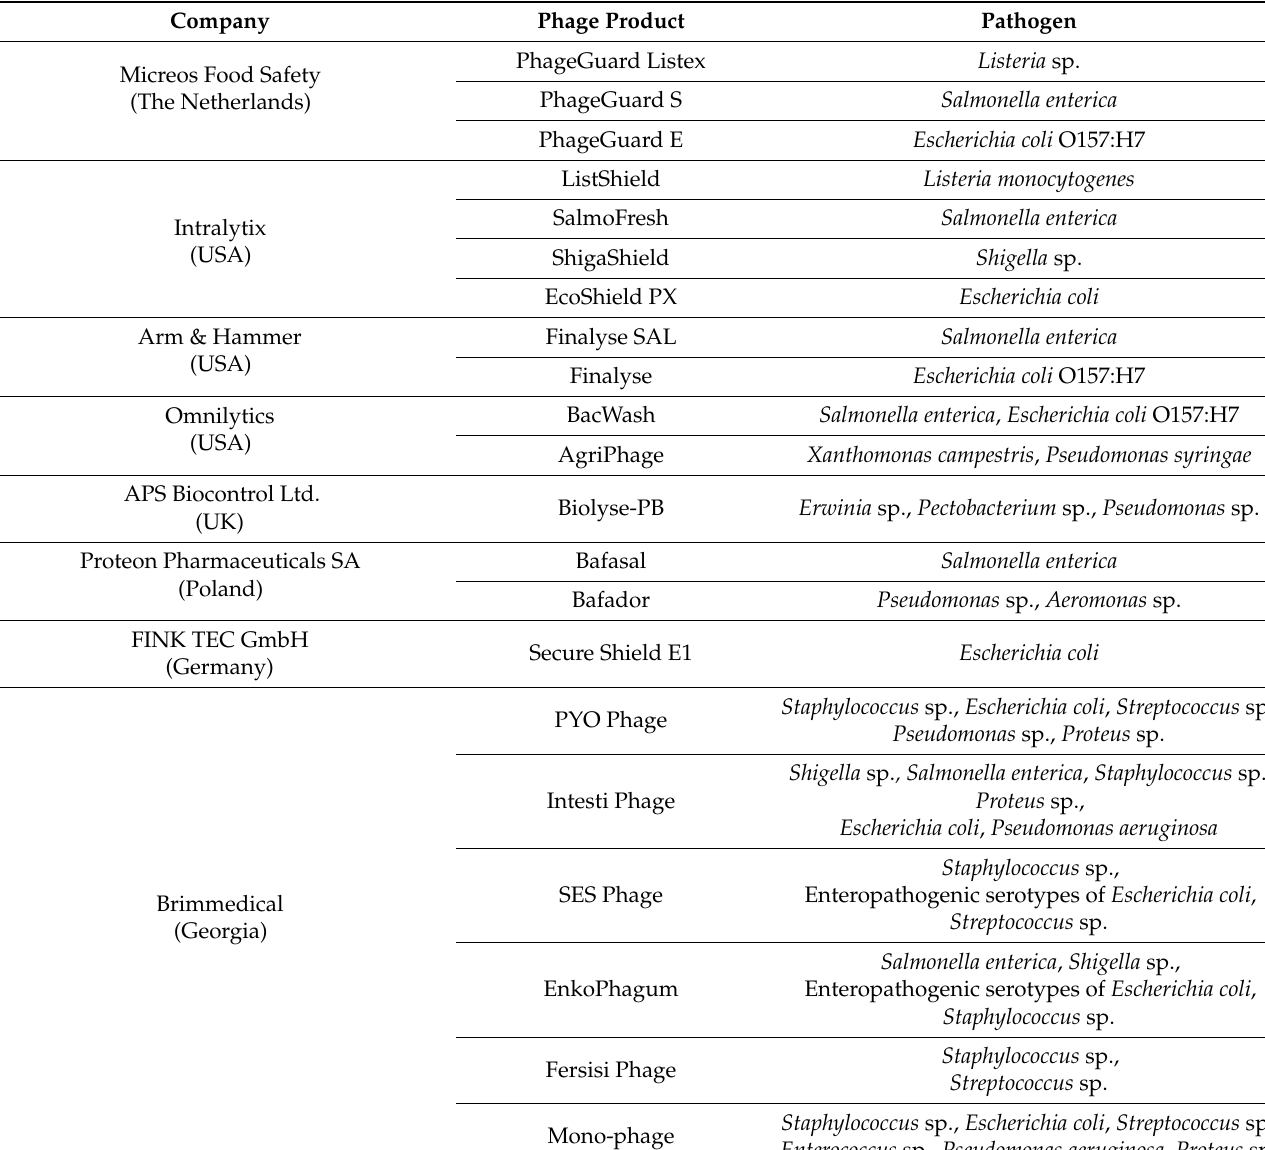
Table 1. List of approved and commercially available bacteriophage